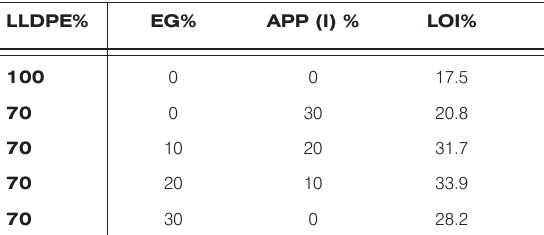
Table 6. LOI Results of samples adding different flame retardants.